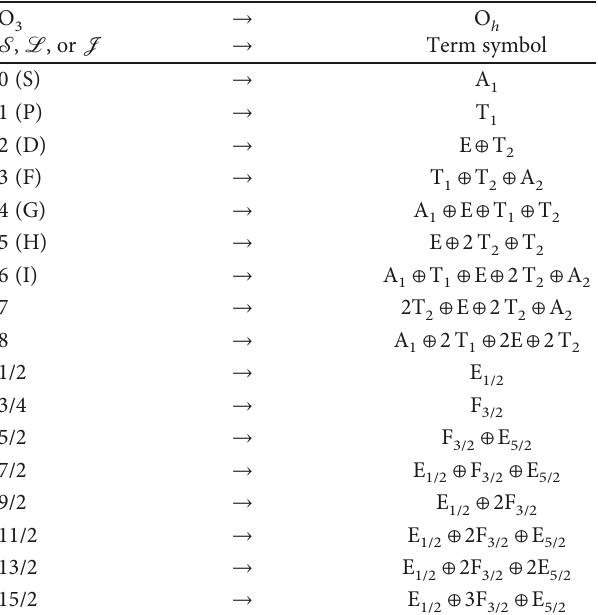
Table 2: Branching of the S , ℒ , and J atomic terms in an → O octahedral crystal fi eld ( O ) [28] (p.262). The fi rst columns 3 h can be either the orbital momentum, the total spin S , or the total angular momentum J . The g for gerade and the u for ungerade must be added to indicate the